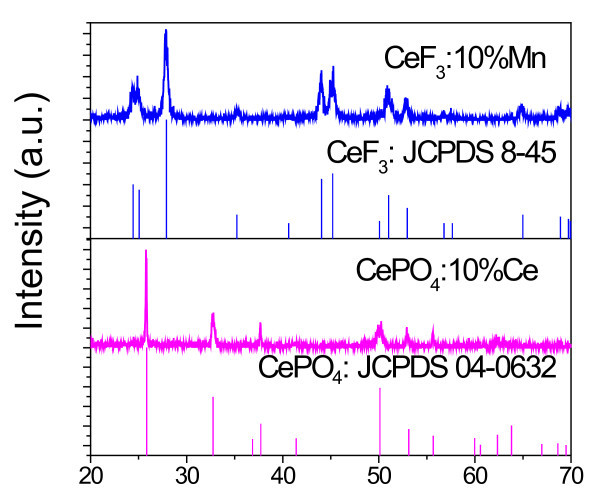
XRD spectra. XRD spectra of CeF3:Mn and CePO4:Mn NCs.